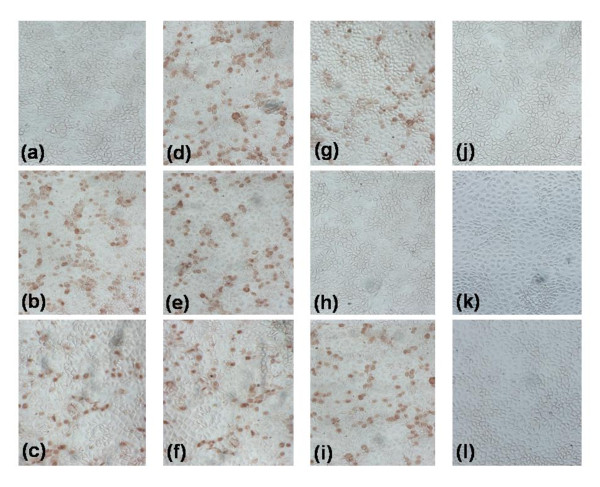
IPMA reactivity between mAb 8E4 and each chimera or mutant.(a) rCL-YJ-1; (b) rCL-YJ-2; (c) rCL-YJ-3; (d) rCL-YJ-4; (e) rCL-YJ-5; (f) rCL-YJ-1-51; (g) rCL-YJ-1-57; (h) rCL-YJ-1-59; (i) rCL-YJ-1-63; (j) rLG-YJ-1-59; (k) rJF2-YJ-1-59; (l) rYJ-CL-1-59.